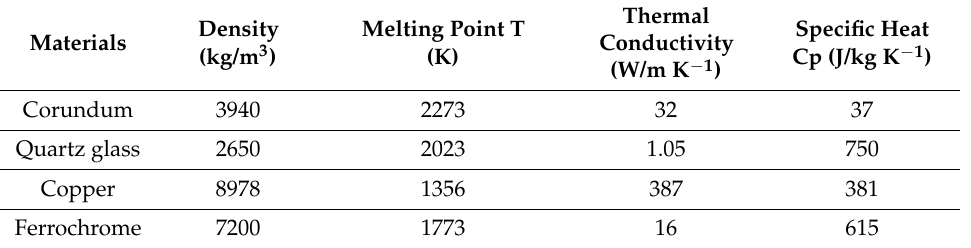
Figure 9. The combustion stability of the combustor at different thermal conductivities [74,76], ( a ) Effect of combustor length on the combustion stability, ( b ) The max. wall temperature and conversion. Table 2. Physical wall material properties